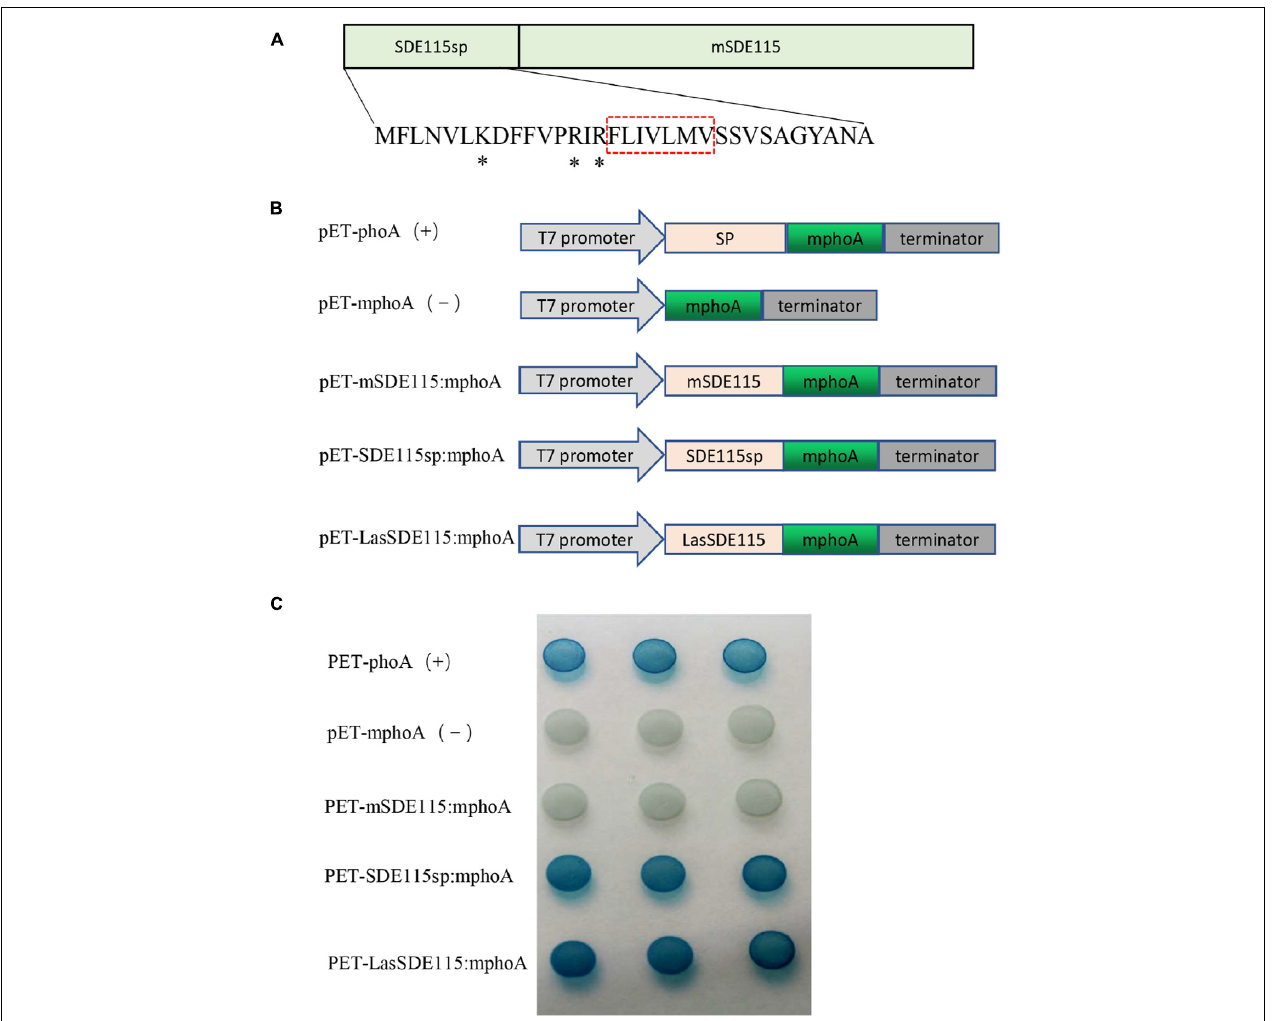
FIGURE 2 | Ca LasSDE115 is a Sec-dependent secretory protein. (A) Structure of the Ca LasSDE115 protein. Its signal peptide and mature protein were named SDE115sp and mSDE115, respectively. *indicated the positively charged amino acids lysine (K) and arginine (R) while the red box indicated the central hydrophobic core. (B) Schematic diagram of the prokaryotic expression cassettes for phoA assay. (C) PhoA assay for the secretion of Ca LasSDE115 in E. coli cells. The data showed that SDE115sp directed the extracellular translocation of mPhoA lacking its native SP and that of Ca LasSDE115:mphoA